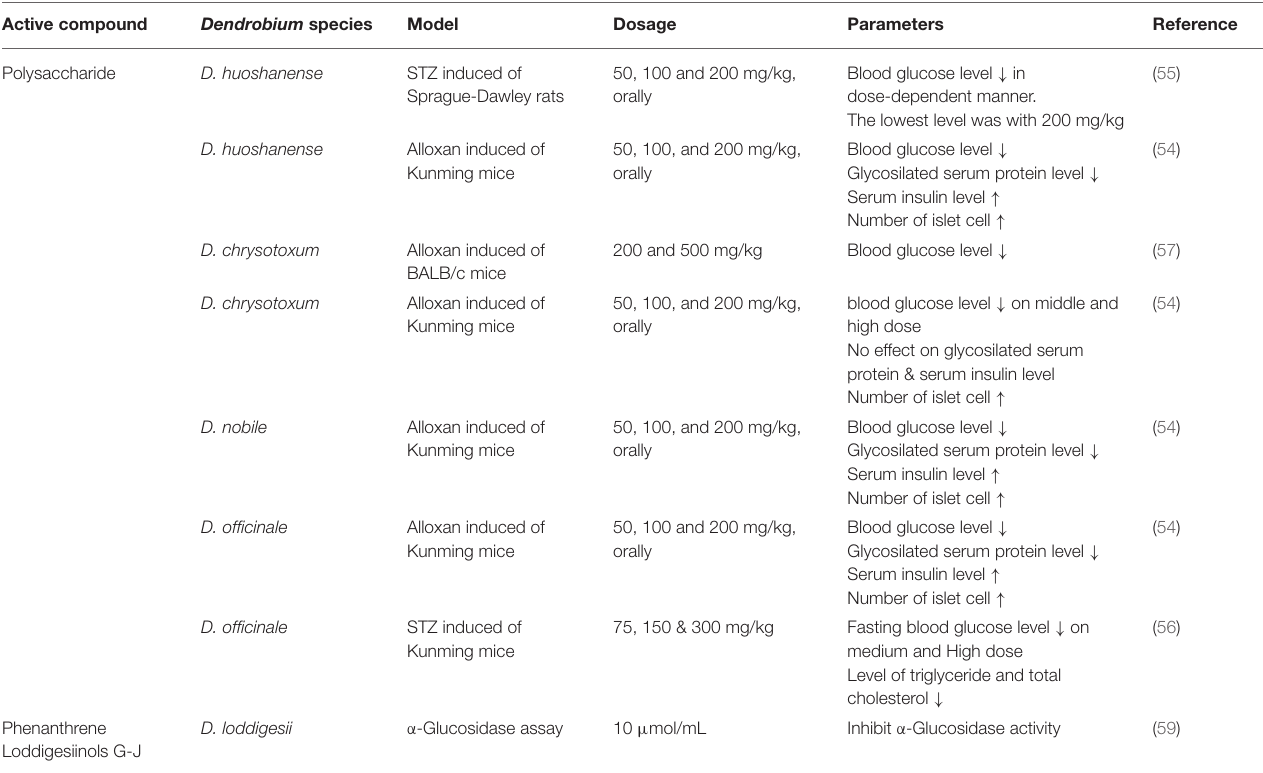
TABLE 1 | Glycemic control activity of Dendrobium